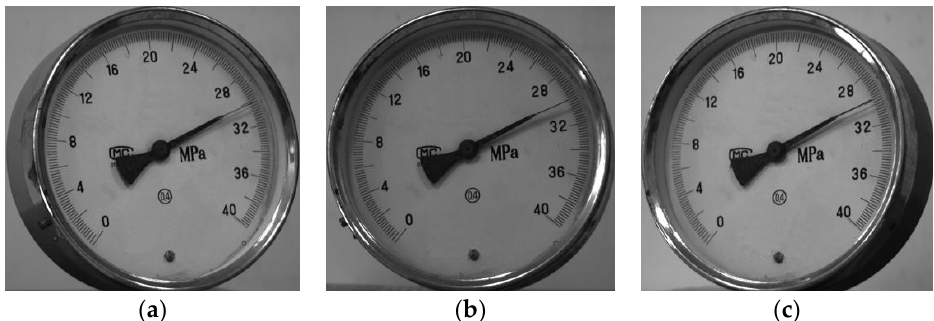
Figure A7. The meter image taken by camera from three angles when the reading of the pointer meter is 26.9; ( a ) the camera at position 1; ( b ) the camera at position 2; ( c ) the camera at position 3.